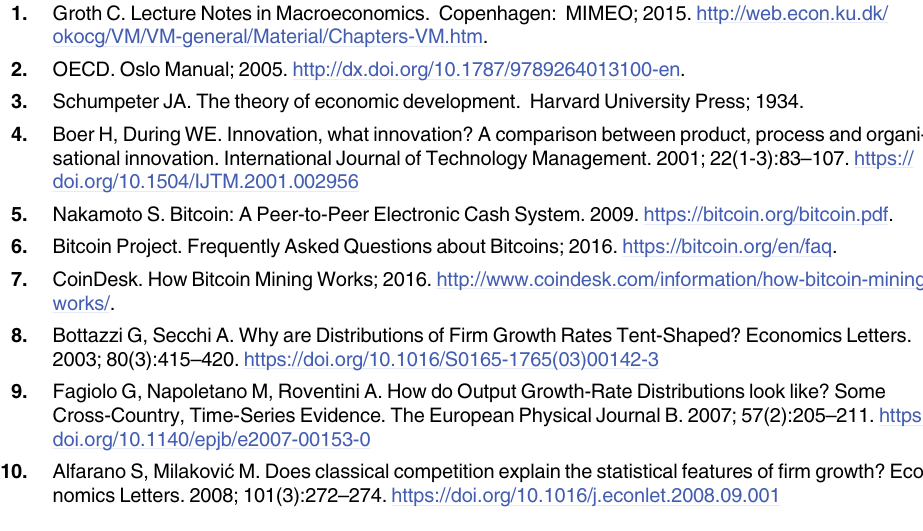
S9 Table. Kolmogorow-Smirnow and Anderson-Darling goodness of fit test statistics for fitted distributions on virtual currency intra-day data. S10 Table. Likelihood ratio test results for virtual intra-day data. S11 Table. Ljung-Box and Box-Pierce test results for virtual intra-day data.